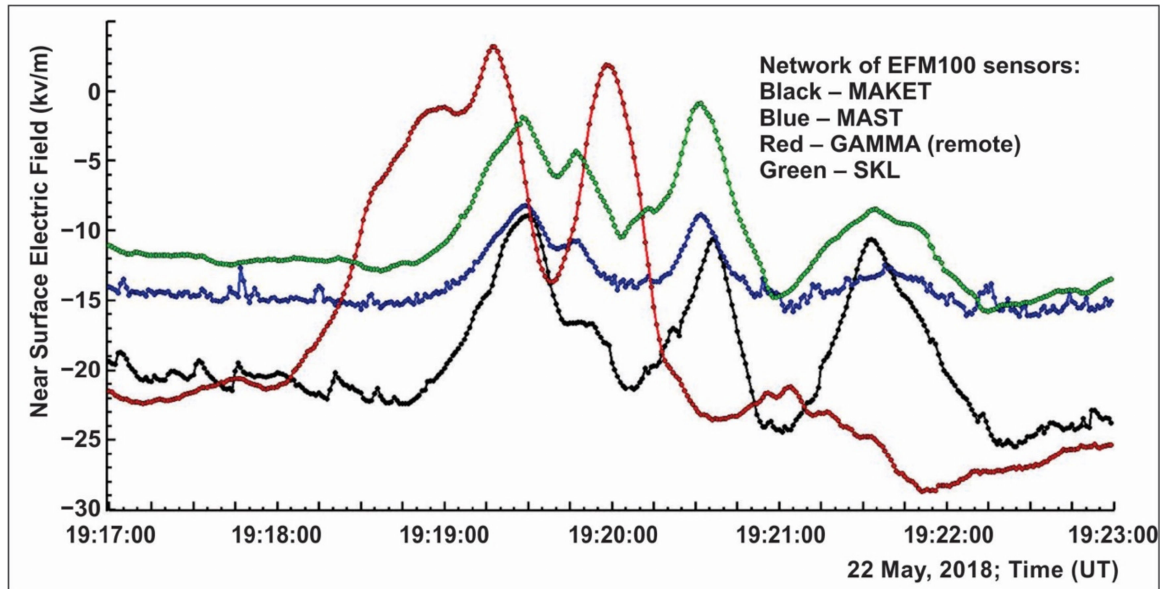
Figure 15. Disturbances of NSEF during 6 min of TGE registered by four electric field sensors of EFM 100